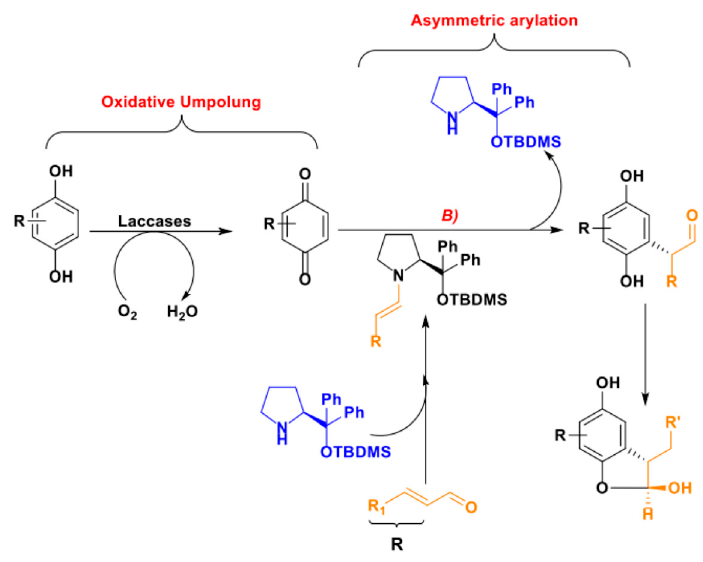
Scheme 38. Catalytic cycle for the laccase-initiated asymmetric 2,3-DHB